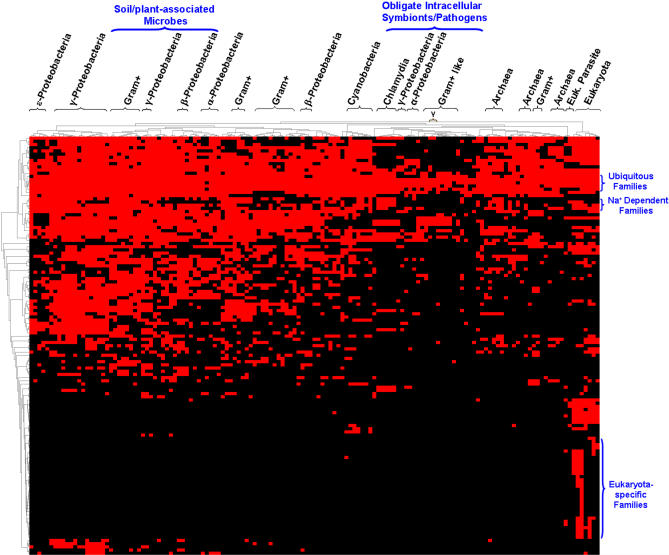
Phylogenetic Profiling of Transporter FamiliesPhylogenetic profiles were created for each transporter family. Each profile is a string with 141 entries (number of organisms analyzed). If a given family is present in an organism, the value one is assigned at this position (red). If not, zero is assigned (black). Organisms and transporter families were clustered according to the similarity of their phylogenetic profiles.